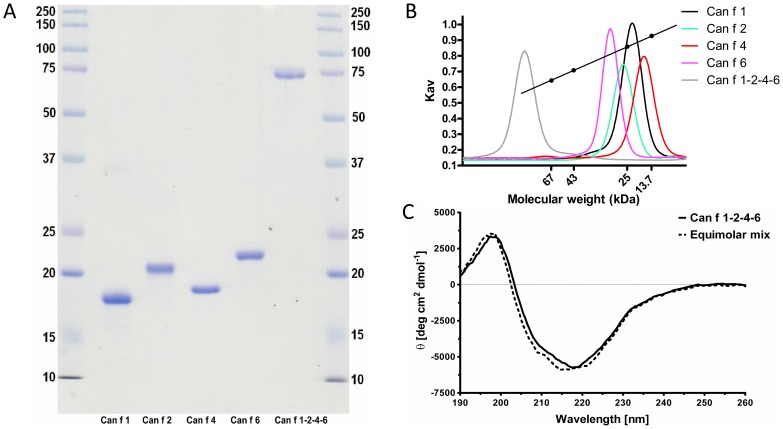
Biochemical analysis of the linked molecule.(A) SDS-PAGE of Can f 1-2-4-6 or the single recombinant lipocalins visualized by coomassie staining under reducing conditions. MW markers (lane 1,7, MW (kDa)), rCan f 1 (lane 2), rCan f 2 (lane 3), rCan f 4 (lane 4), rCan f 6 (lane 5) and Can f 1-2-4-6 (lane 6). (B) Analytical size exclusion chromatography of rCan f 1-2-4-6 and the single lipocalin allergens. Molecular weight markers, bovine serum albumin (67 kDa), ovalbumin (43 kDa), chymotrypsinogen A (25 kDa) and Ribonuclease A (13.7 kDa). (C) Far-UV CD analysis of Can f 1-2-4-6 or an equimolar mix of the single recombinant allergens Can f 1, Can f 2, Can f 4 and Can f 6. The spectra are expressed as mean residue ellipticities (θ) at a given wavelength.